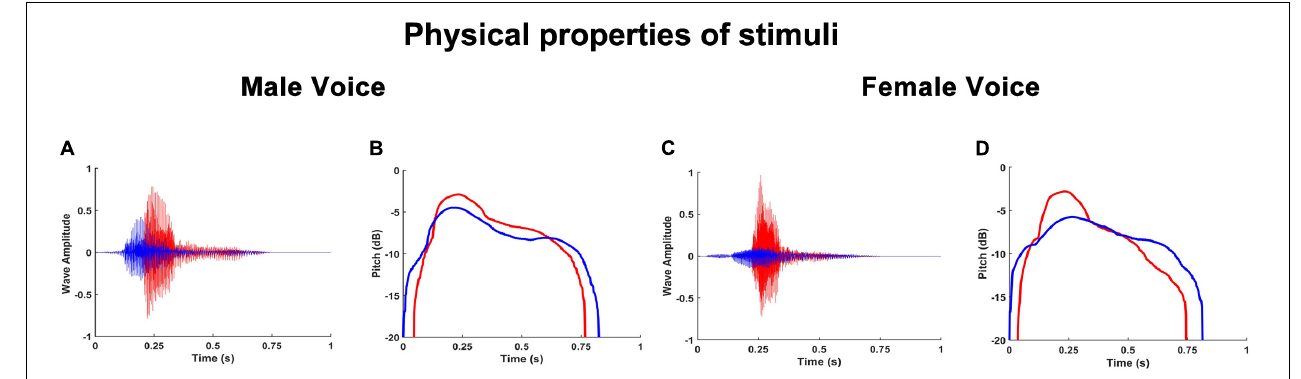
FIGURE 2 | Graphs show the wave amplitude of man (A) and woman (C) voices; the pitch of man (B) and woman (D) voices. Red color refers to rude vitality form and blue color refers to gentle vitality